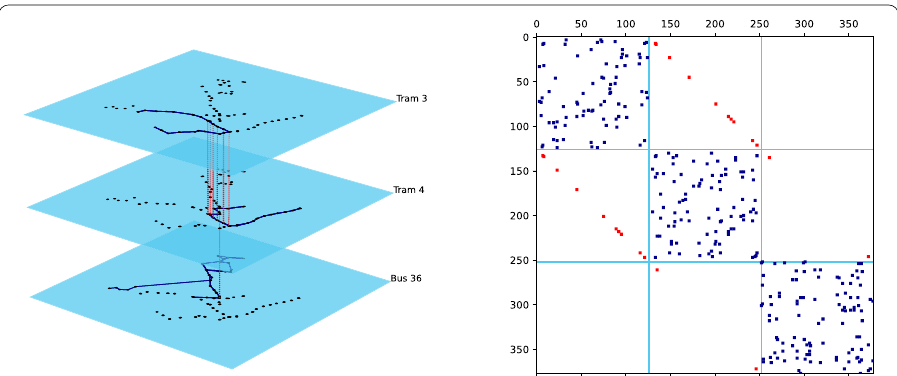
Fig. 6 Example public transport multiplex network with L = 3 selected layers of Freiburg (corresponding to two tram layers and one bus layer) and n = 126 stops. The graphics were created with the python package pymnet (Kivelä 2017). Left: Visualization of the multiplex network. Intra-layer edges are marked dark blue and inter-layer edges are marked red. Right: Sparsity structure of the corresponding supra-adjacency matrix. Dark blue entries represent intra-layer edges and red entries represent inter-layer